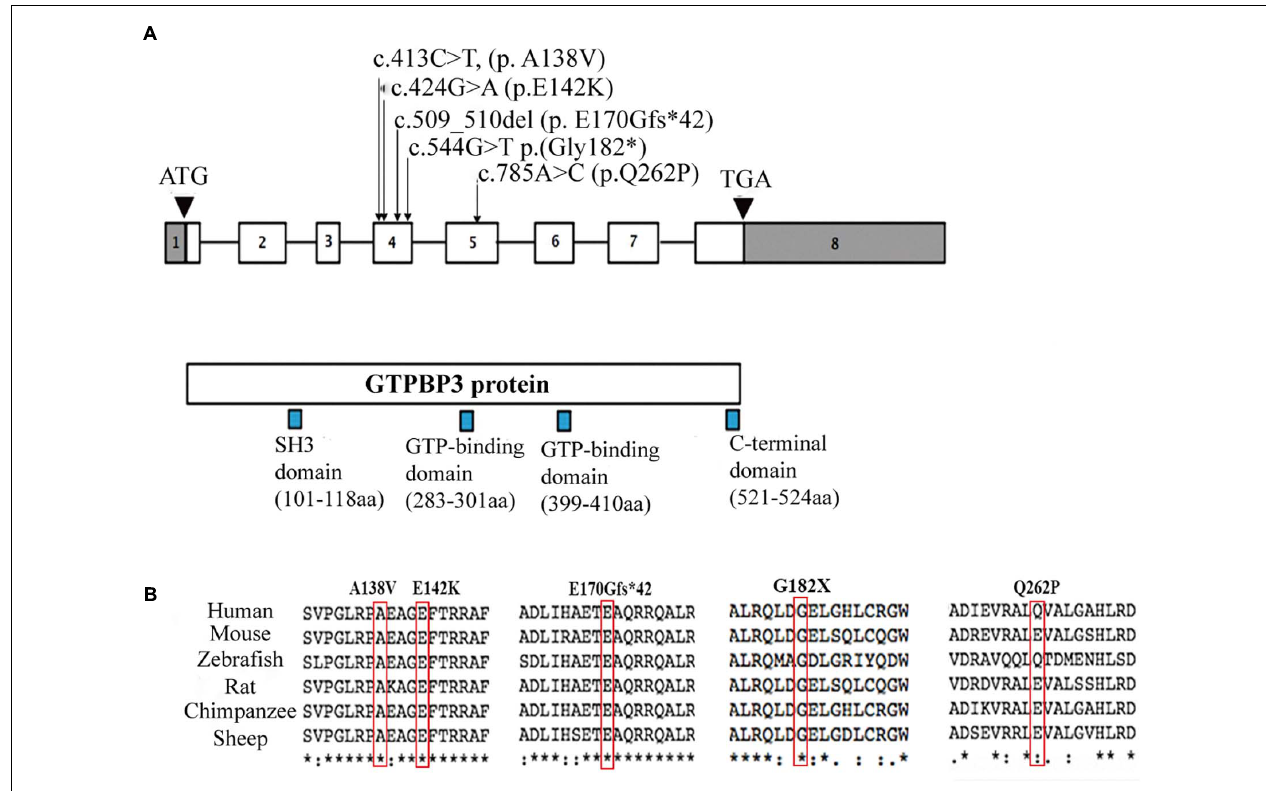
FIGURE 2 | Localizations and amino acids conservative analysis of GTPBP3 mutations. (A) Schematic presentation of GTPBP3 gene structure and the locus of identified mutations. Square indicates exons and line indicates introns. (B) Amino acids conservative analysis of the mutations among species.